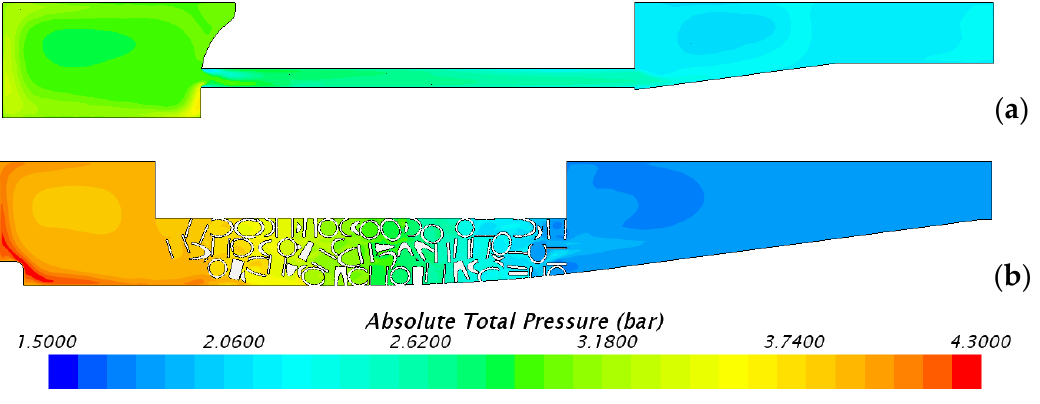
Figure 17. Pressure maps computed on a longitudinal section for the mock-up equipped with MCs ( a ) and RRs ( b ).